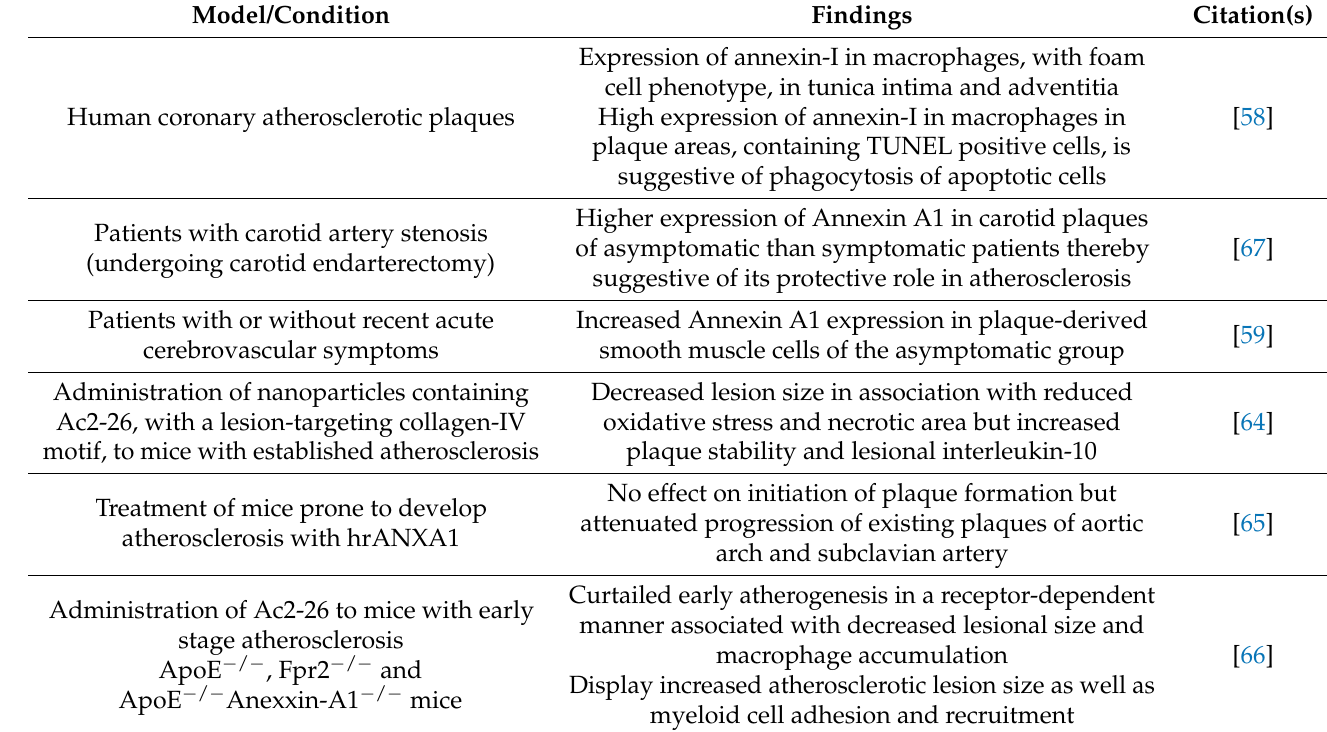
Table 2. Role of and therapeutic potential of Annexin A1 in